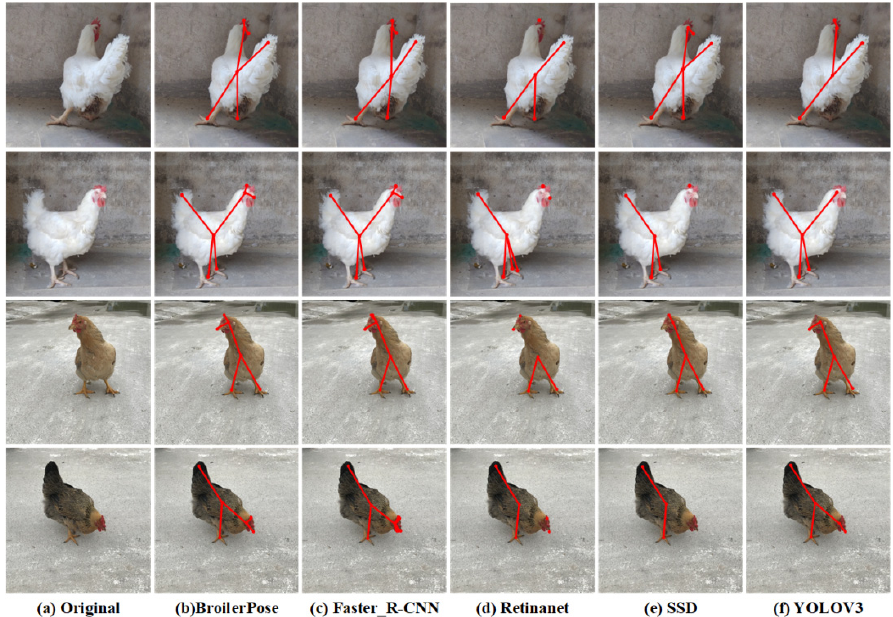
Figure 7. Partial results of posture comparison of broiler chickens.